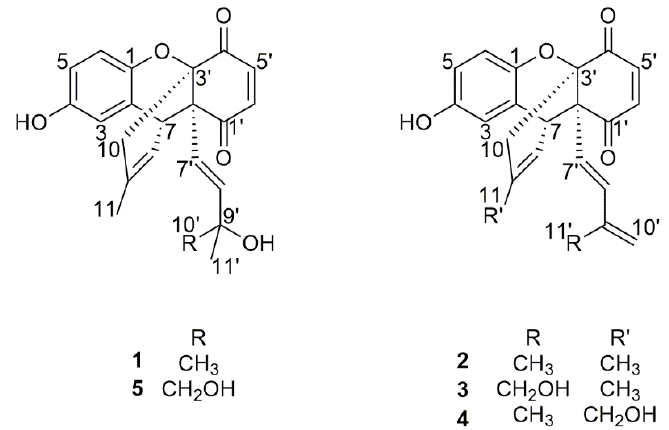
Figure 1. Chemical structures of allomicrophyllone ( 1 ), ehretiquinone ( 2 ) and ehretiquinones B–D ( 3 – 5 ).